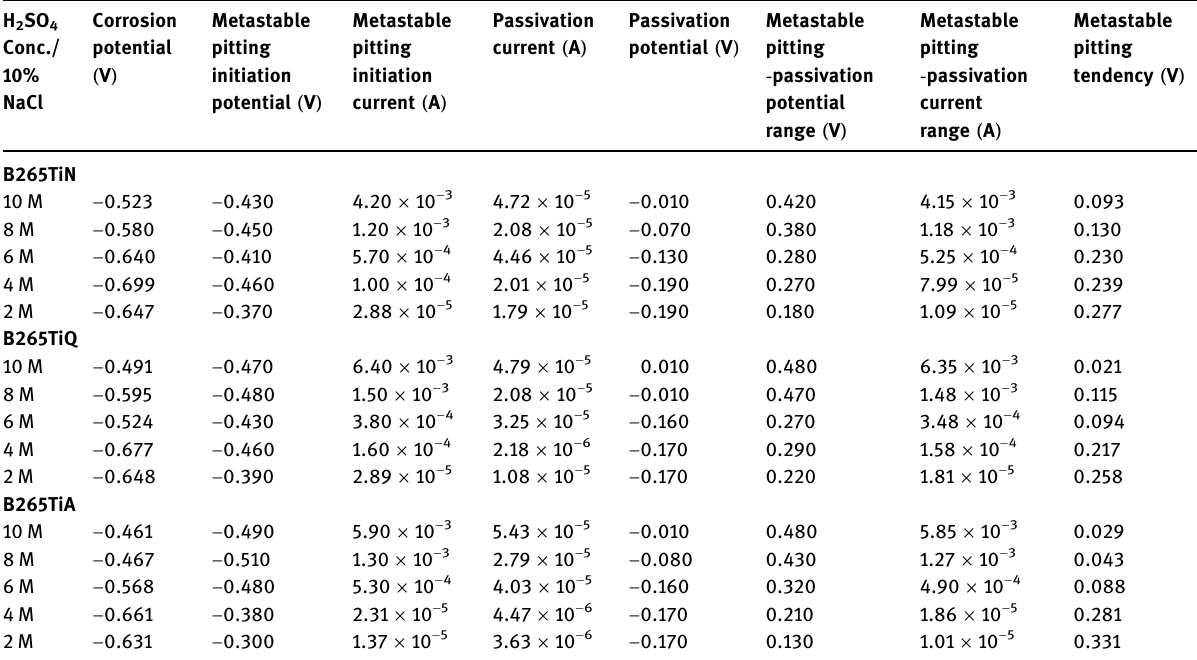
Table 4: Potentiostatic data for B265TiN, B265TiQ, and B265TiA metastable pitting activity and passivation behavior in 2 – 10 M H 2 SO 4 + 10% NaCl at 30°C